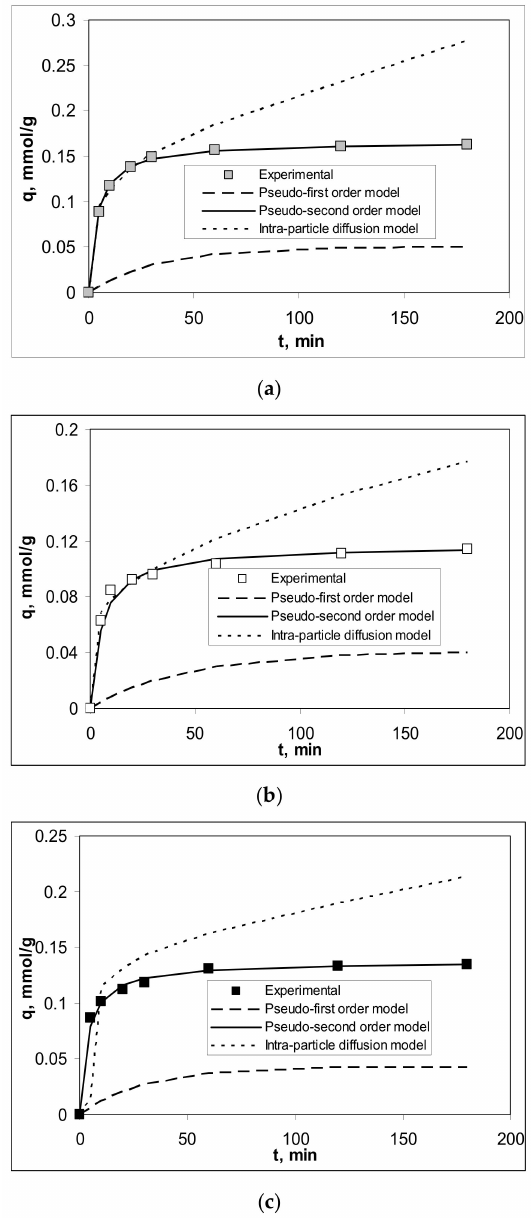
Figure 6. Experimental and theoretical kinetic curves obtained for the biosorption of ( a ) Cu(II), ( b ) Co(II) and ( c ) Zn(II) ions on Alg-Fe 3 O 4 -MPs. (Experimental conditions: pH = 5.4; adsorbent dosage = 2.0 g/L; initial metal ions concentration = 0.80 mmol/L; temperature = 23 ◦ C). The values of the rate constants of the pseudo-second order model (k 2 , mmol/g min) increase in the order Cu(II) < Co(II) < Zn(II) (Table 4), which indicate that Zn(II)